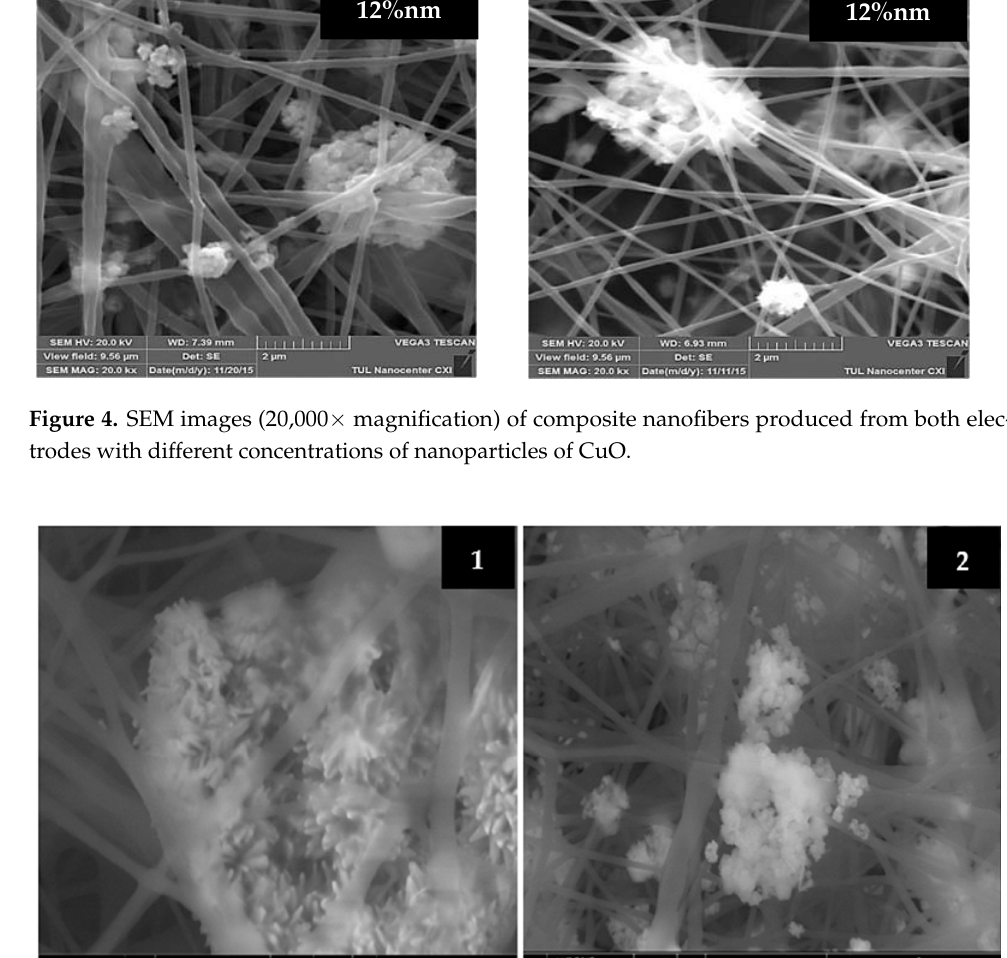
Figure 5. SEM images of PU nanofibres with 7% ( 1 ) and 12% ( 2 ) of CuO NPs produced from rotat ‐ ing electrode with a needle surface (60,000x magnification).